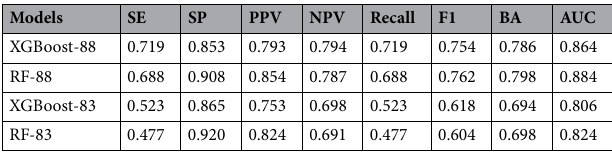
Table 3. Performance of machine learning algorithms in testing set (n =